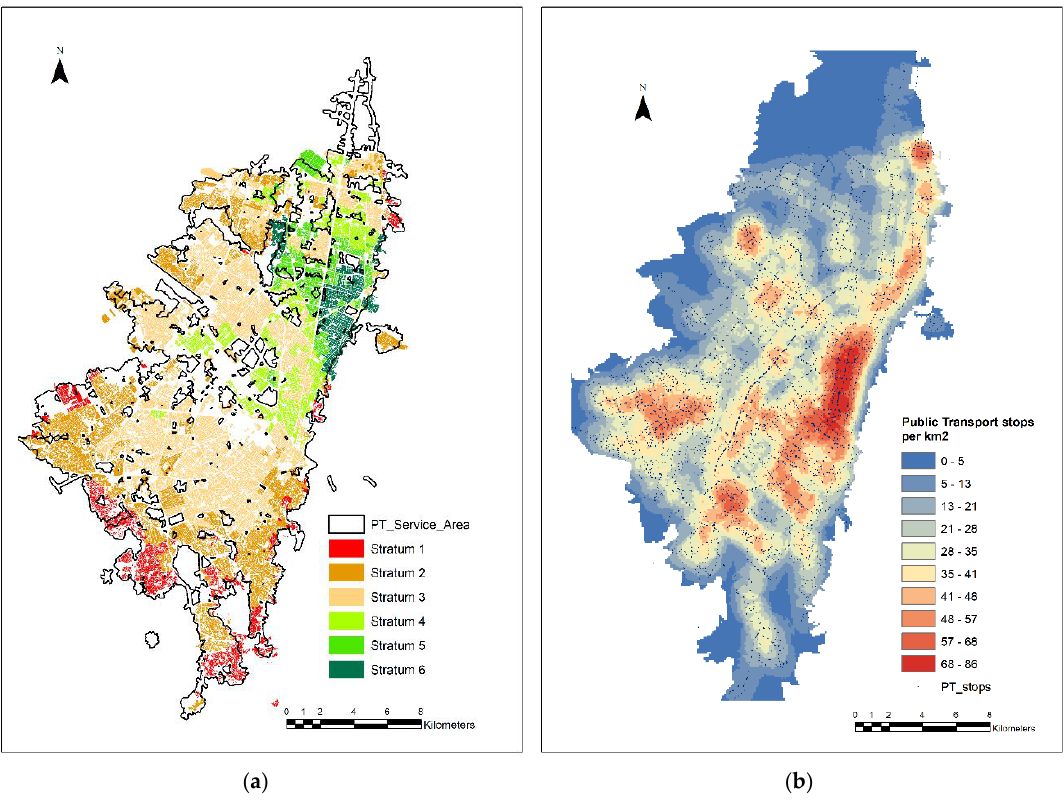
Figure 3. Resulting map of Sustainable Development Goals (SDG) indicator 11.2 depicting Service area of public transport ( a ), and the density of public transport stops ( b ).